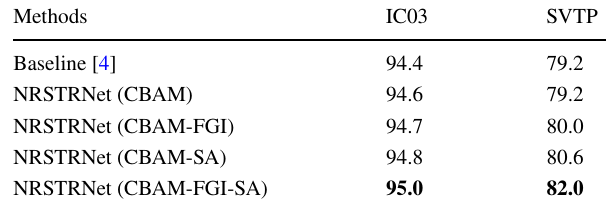
Table 2 Accuracy after adding modules one by